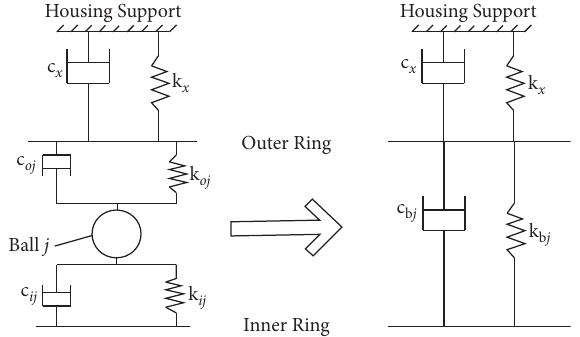
Figure 11: Comprehensive stiffness mechanical